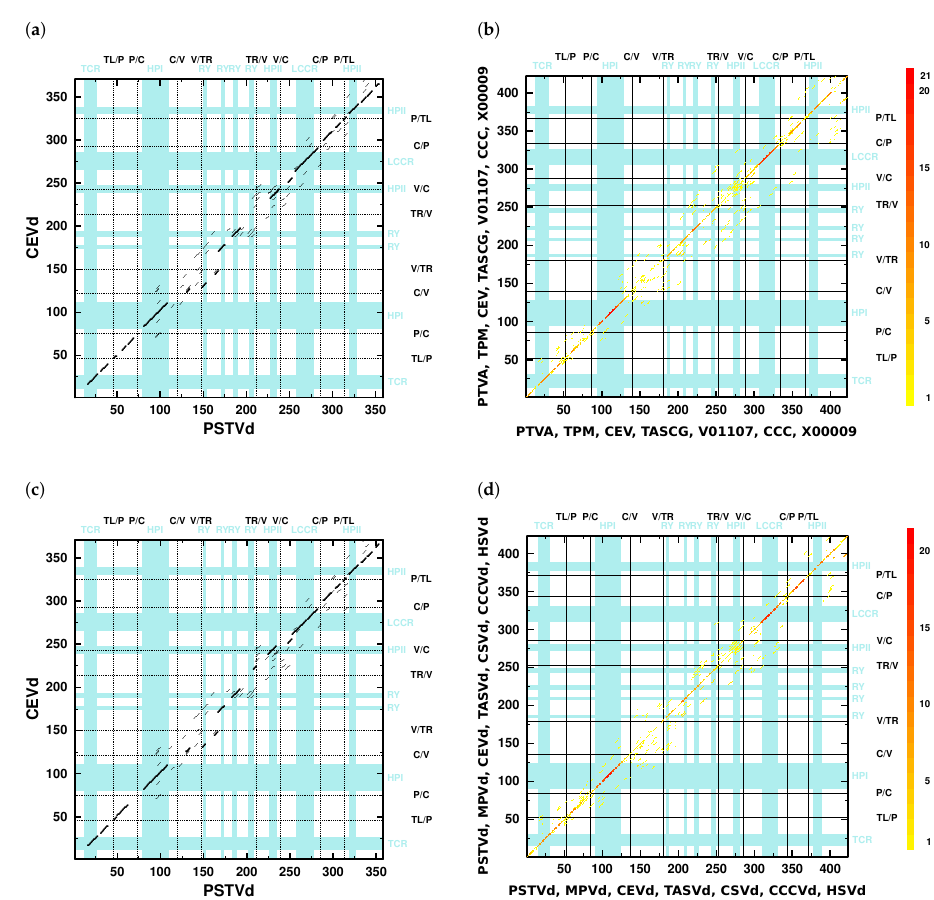
Figure 2. Dotplots of single sequences (left) and dotplot overlay of the seven sequences used by Keese and Symons [11,52] to establish the domain boundaries. ( a , c ): Grey and black diagonal lines show regions with at least four consecutive nucleotides that match between the two sequences, black lines show the best overall matches according to N UC A LN with parameters k = 4, g = 4 and w = 25. In ( a ), the original sequences were used (PSTVd, GenBank Locus PTVA, NC_002030; CEVd, CEV); in ( c ), consensus sequences for PSTVd (274 sequences) and CEVd (217 sequences) were used. ( b , d ): Overlay of N UC A LN best matches ( k = 4, g = 4, w = 25) on a MAFFT X-INS- I alignment of the original seven sequences (( b ); PSTVd, PTVA, NC_002030; MPVd, TPM; CEVd, CEV; TASVd, TASCG; CSVd, V01107; CCCVd, CCC; HSVd, X00009) and the corresponding seven consensus sequences (( d ); 274 PSTVd sequences, 15 MPVd, 217 CEVd, 24 TASVd, 215 CSVd, 13 CCCVd, 433 HSVd), respectively. That is, plot ( b , d ) show an overlay of the dotplots of Figure S5 and of Figure S6, respectively. The number of coinciding matches is color-coded from red (7 6/2 = 21) to yellow (1). Domain boundaries according to Keese and Symons [52] are marked by black lines (TL, terminal left; P, pathogenicity; C, central; V, variable; TR, terminal right); in ( c , d ), boundaries for PSTVd are shown. Blue bars and labels mark TCR (Figure S20), HPI (Figures 1b and S22a), LCCR (Figure S22b), HPII (Figures 1c and S25), and RY motifs (Figures 1d and S26).